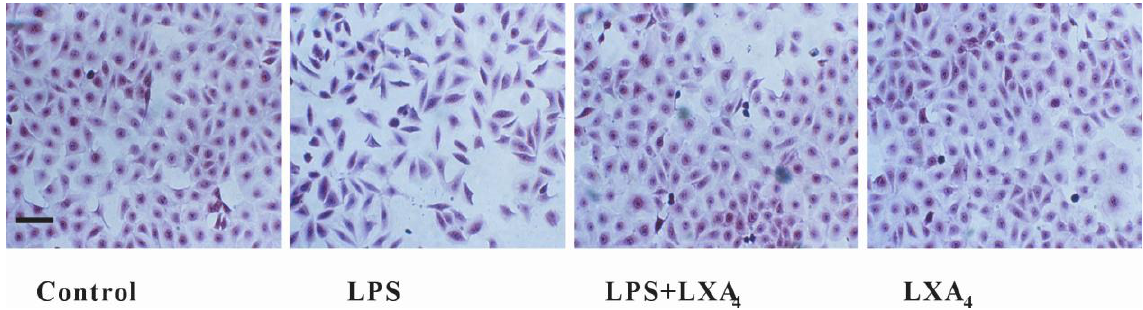
FIGURE 2. LXA maintained the normal morphology of HUVECs. Representative images were from one of 4 three separate experiments that yielded similar